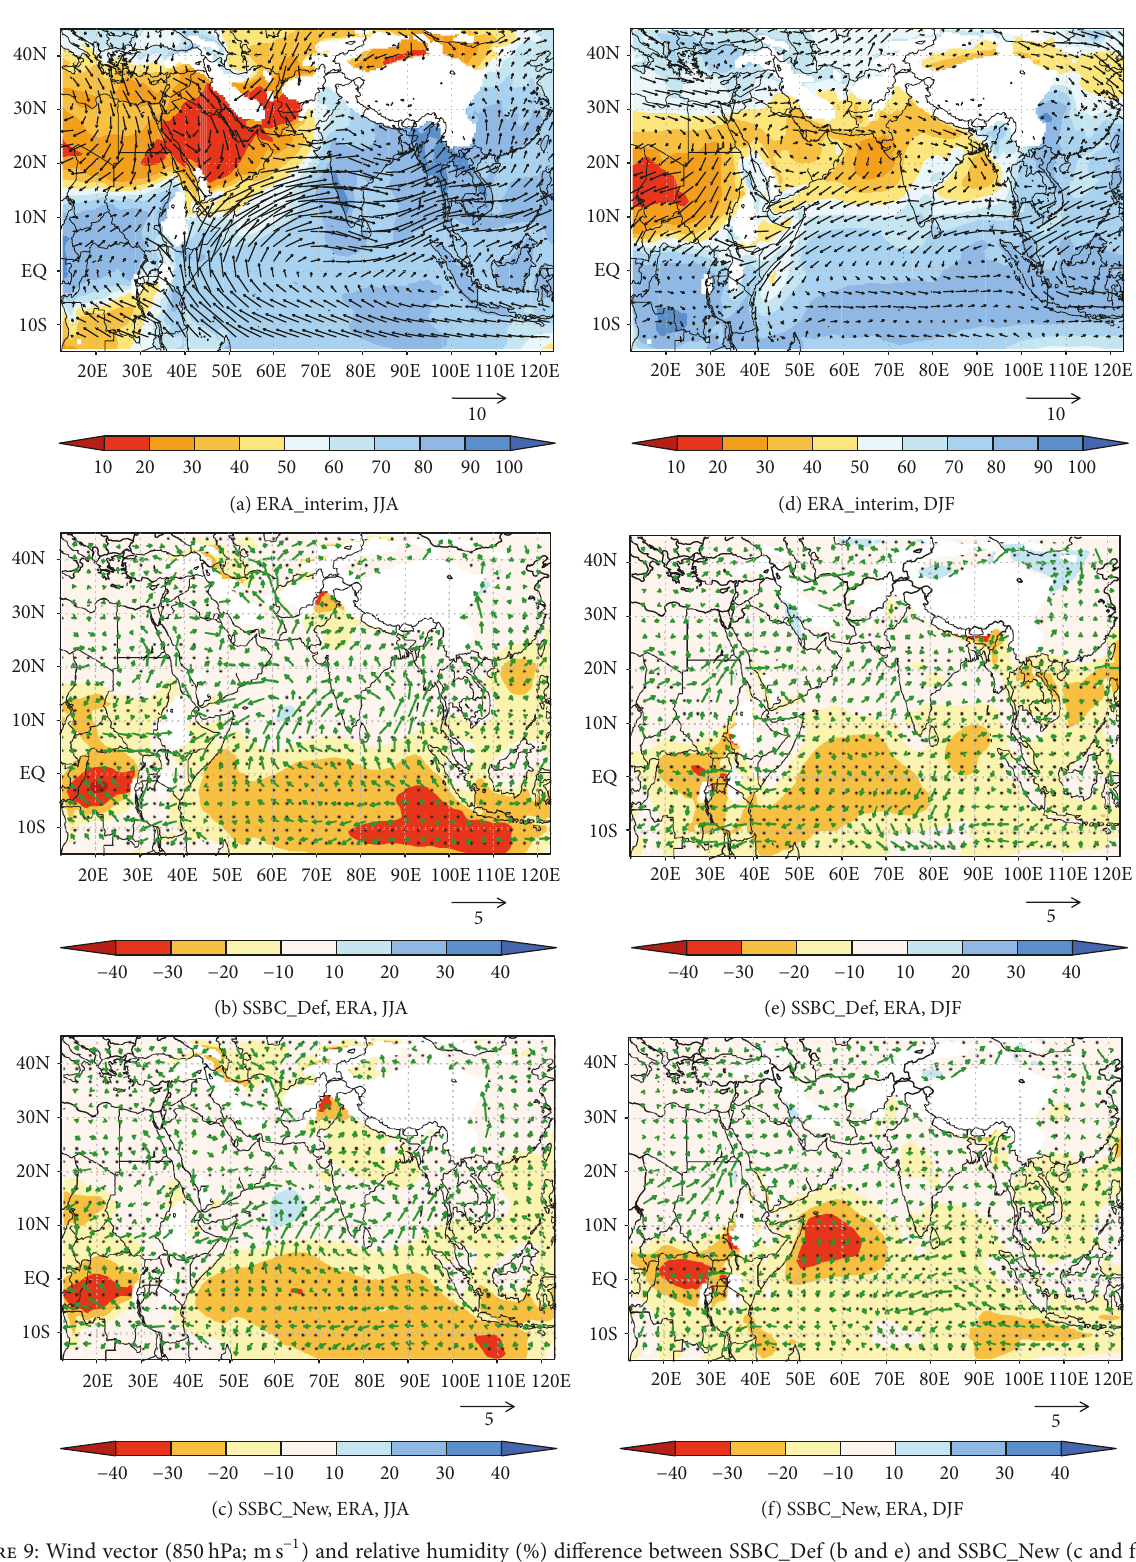
Figure 9: Wind vector (850hPa; ms −1 ) and relative humidity (%) difference between SSBC_Def (b and e) and SSBC_New (c and f) from ERA_interim reanalysis for JJA and DJF, 1981–1990. The red color is for dry and the blue color is for wet bias of relative humidity. The statistically significant regions at 99% confidence level shaded as black